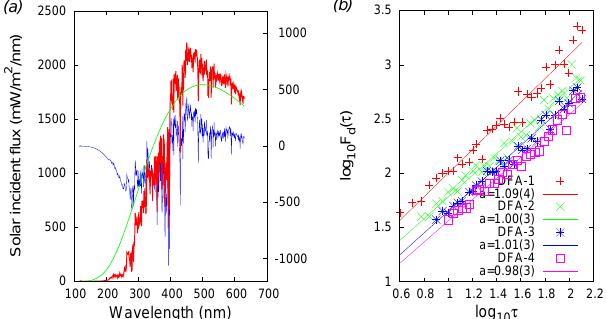
Figure 1. (a) SIF values (red, left scale) on the top of the atmosphere vs. WL from 115.5 to 629.5nm together with the fitting employed (green, left scale). The detrended SIF data (blue, right scale) are also shown. (b) Log-log plot of the root mean square fluctuation function F d (τ) of the detrended SIF vs. the WL segment size τ , for the wavelengths between 115.5 and 629.5nm. The a values for DFA-1, DFA-2, DFA-3, DFA-4 are 1.09 ( ± 0.04), 1.00 ( ± 0.03), 1.01 ( ± 0.03), 0.98 ( ± 0.03),